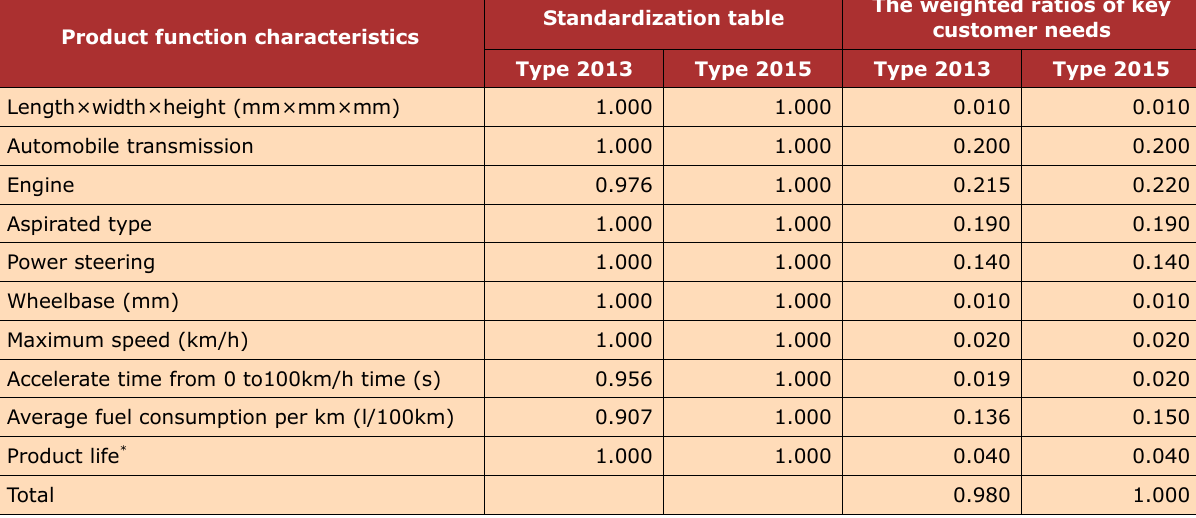
Table 3. the product function value ratio between type 2013 and type 2015